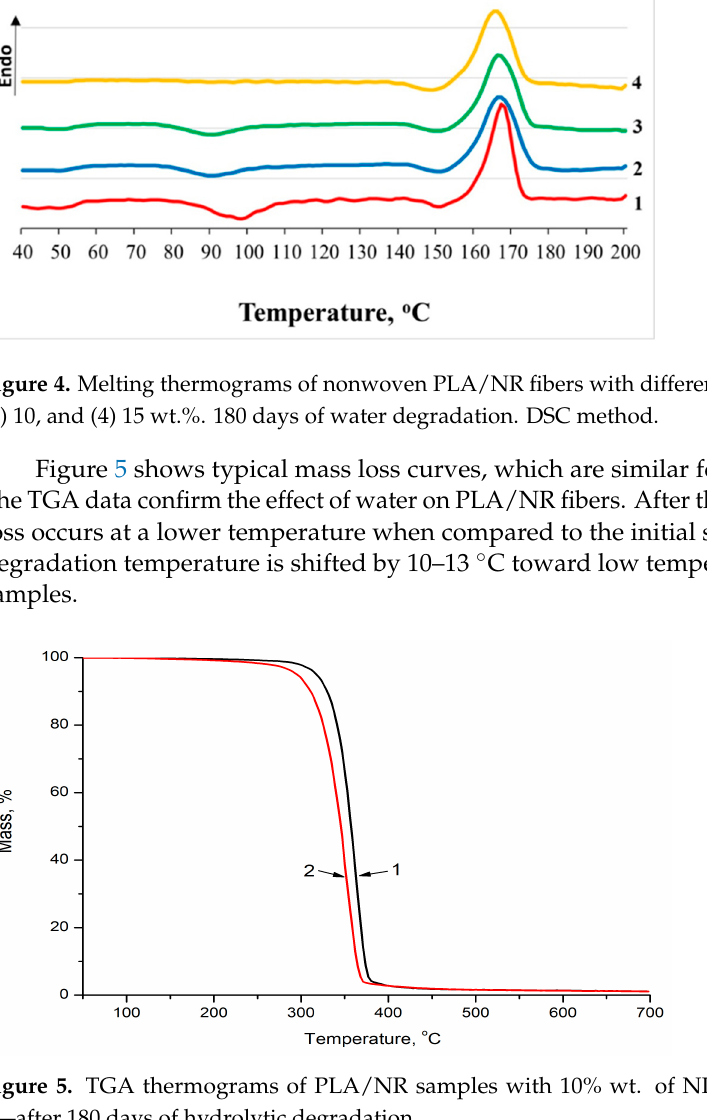
Figure 4. Melting thermograms of nonwoven PLA/NR fibers with different NR contents: (1) 0, (2) 5, (3) 10, and (4) 15 wt.%. 180 days of water degradation. DSC method.